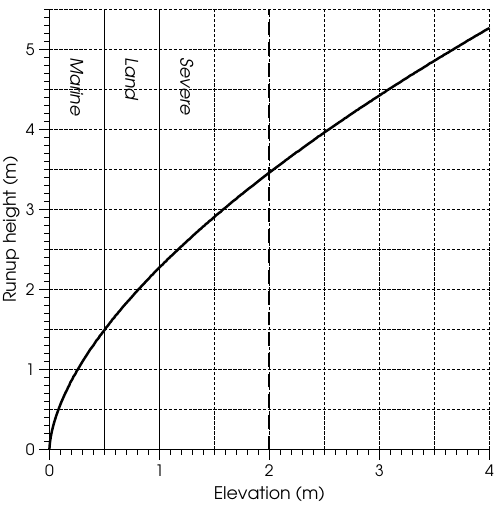
Fig. 9. Graph showing the wave elevation – run-up height relation of Synolakis (1987) for a breaking wave. The thick vertical grid lines show the threat levels of Tiberti et al.